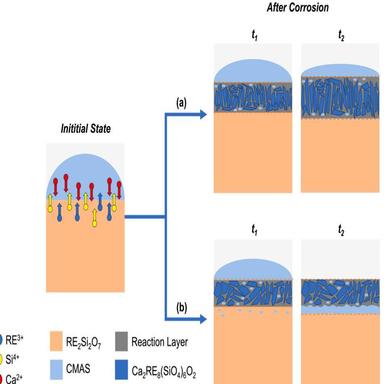
Schematic CMAS corrosion mechanism diagrams for (a) (Y0,25Er0,25Tm0,25Yb0,25)2Si2O7 and (b) Yb2Si2O7.